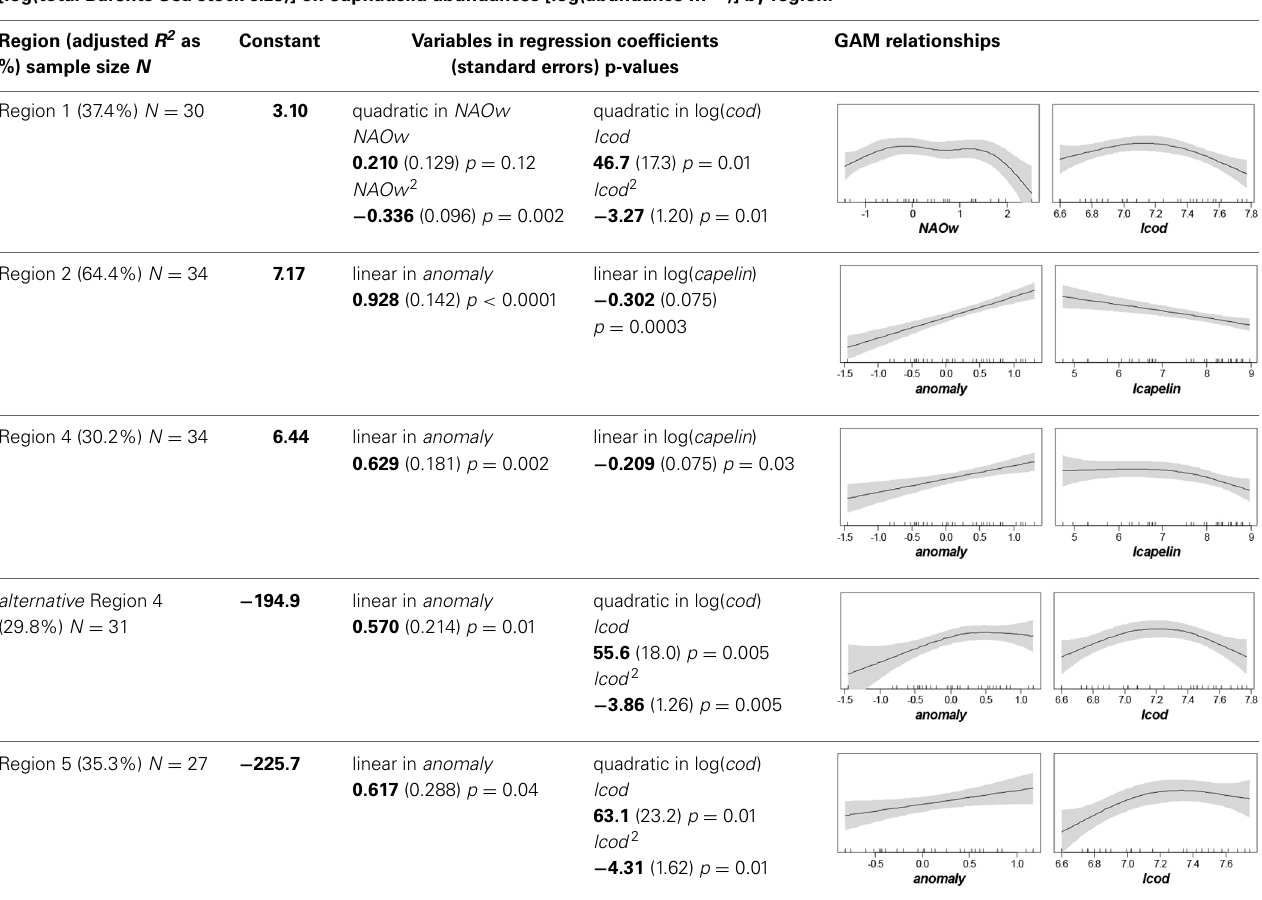
Table 2 | Results of the best multiple regressions and general additive models (GAM) describing impact of climatic and predator abundances [log(total Barents Sea stock size)] on euphausiid abundances [log(abundance m − 3 )] by